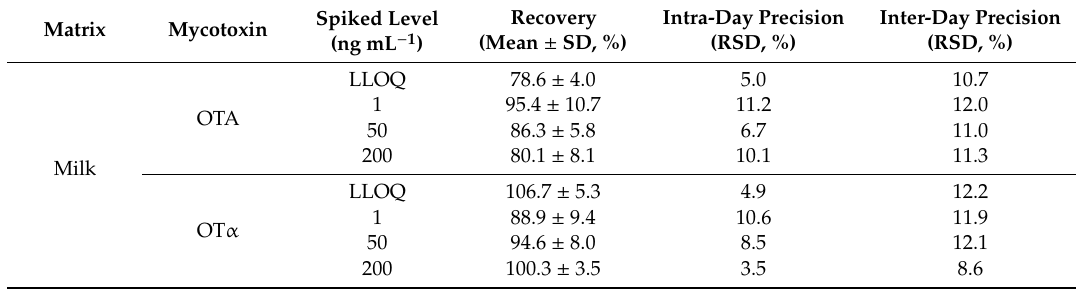
Table 2. Recoveries, intra-and inter-day precisions of ochratoxin A (OTA), and ochratoxin α (OT α ) in di ff erent matrices ( n =